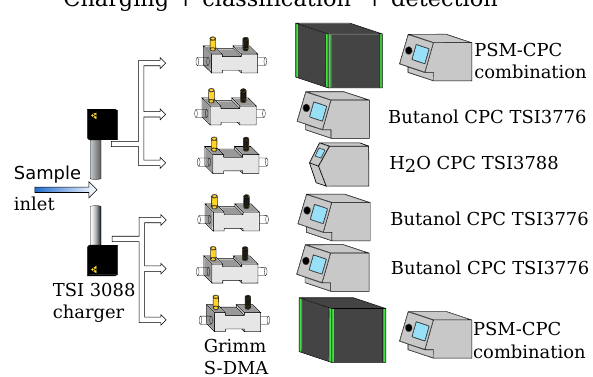
Figure 1. Scheme of the DMA-train setup. The design follows a classical SMPS design in each channel. After bringing the aerosol to a well-defined charging state, it is split and classified in six iden- tical Grimm S-DMAs and subsequently detected in condensation particle counters. For optimal detection of sub-2.5nm particles a combination of a Airmodus A10 particle size magnifier (PSM) with a butanol-based TSI 3776 CPC is used. Particles equal or larger than 2.5nm are detected by either TSI model 3776 or TSI model 3788 CPCs to allow for maximum flexibility with respect to particle ac- tivation properties. The whole setup measures 80 × 135 × 140cm, excluding the flow supply unit.